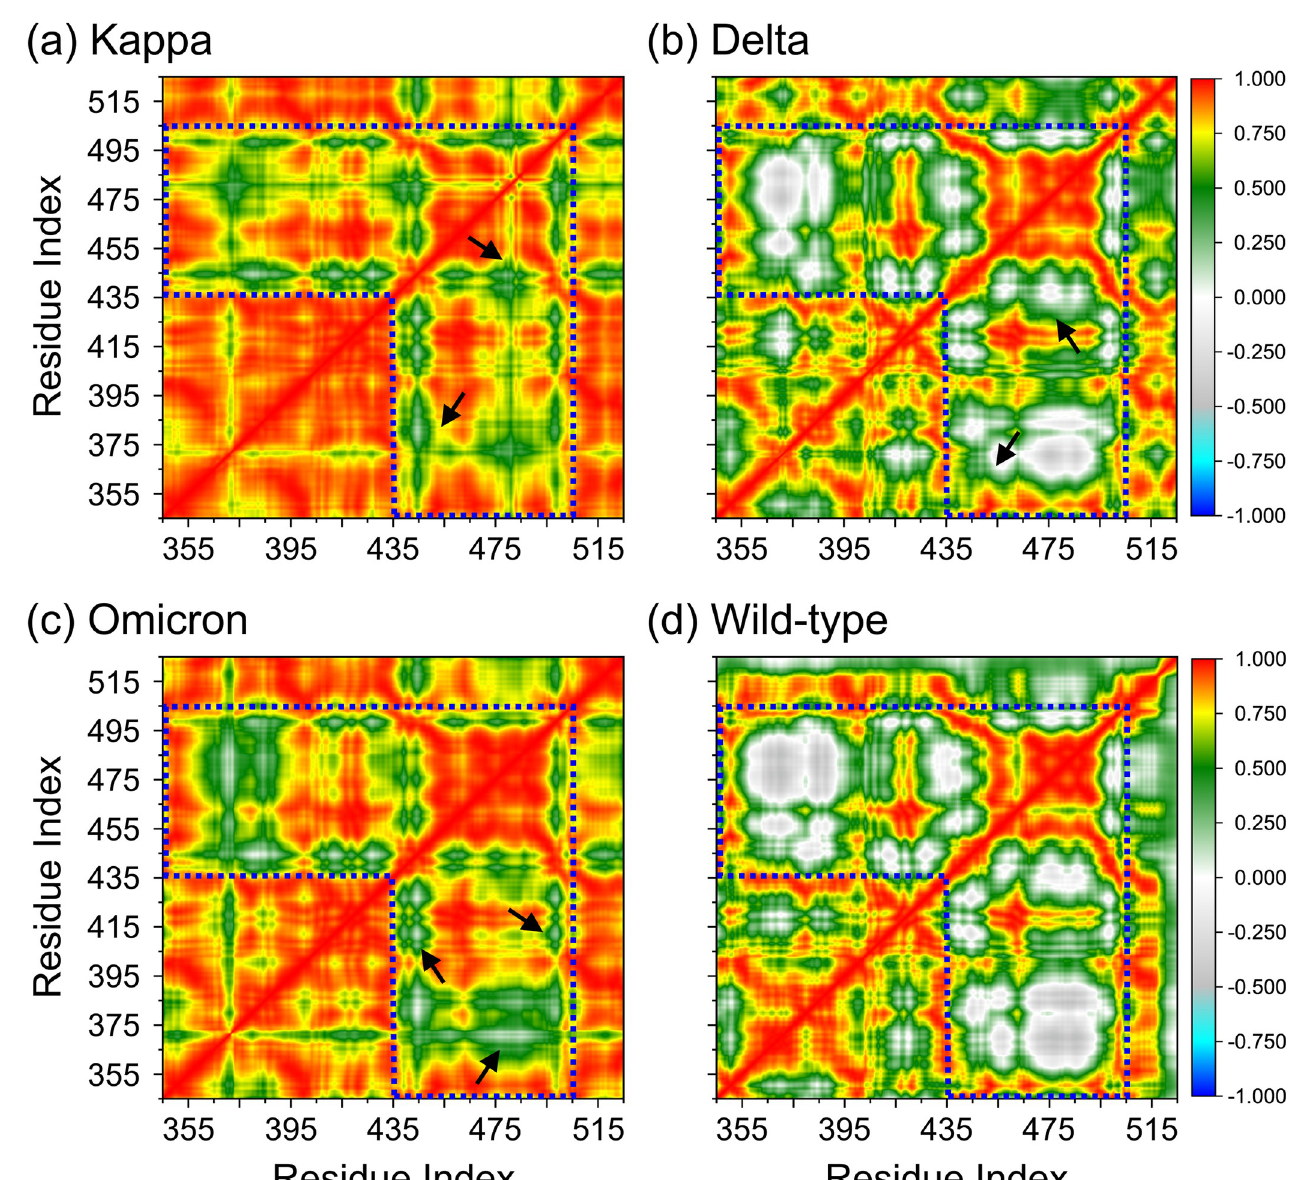
Fig 7. Dynamic cross-correlation diagrams of the fluctuations of C α –atoms of SARS-CoV-2 spike RBD protein in the various variants of (a) Kappa, (b) Delta, (c) Omicron in comparison to the (d) wild-type RBD protein. Positive and negative values are represented in range of color deep red to royal blue, respectively. The diagonal square relates to the correlation of a residue with itself, i . e ., only a region remarked to have highly-positive values (red). Black arrows point to the mutation position of each variant that observed for ACE2 binding. The ACE2 binding regions of the SARS-CoV-2 spike RBD protein, at residues number of 438–505, are demarcated with dashed